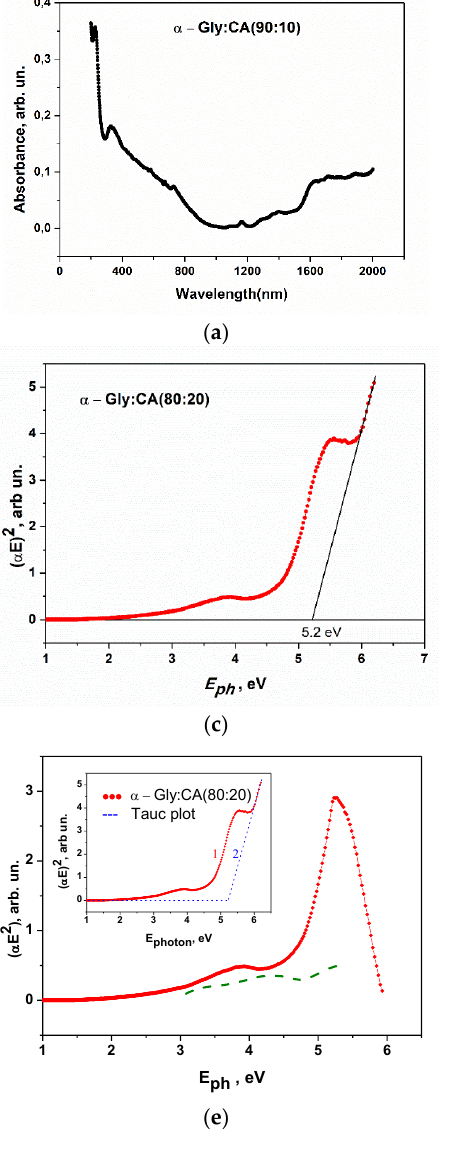
Figure 7. Absorbance spectra of ( a ) α -Gly:CA (90:10), ( b ) γ -Gly:CA (80:20), ( c ) α -Gly:CA (90:10), and ( d ) γ -Gly:CA (80:20) in Tauc coordinates. ( e , f ) Change in the Gly crystal absorption caused by incorporating CA molecules into the Gly crystals. The olive lines represent the absorption spectrum of CA solution in ethanol [60]. The inset portrays the absorption spectra of doped and pure Gly crystals (see text).